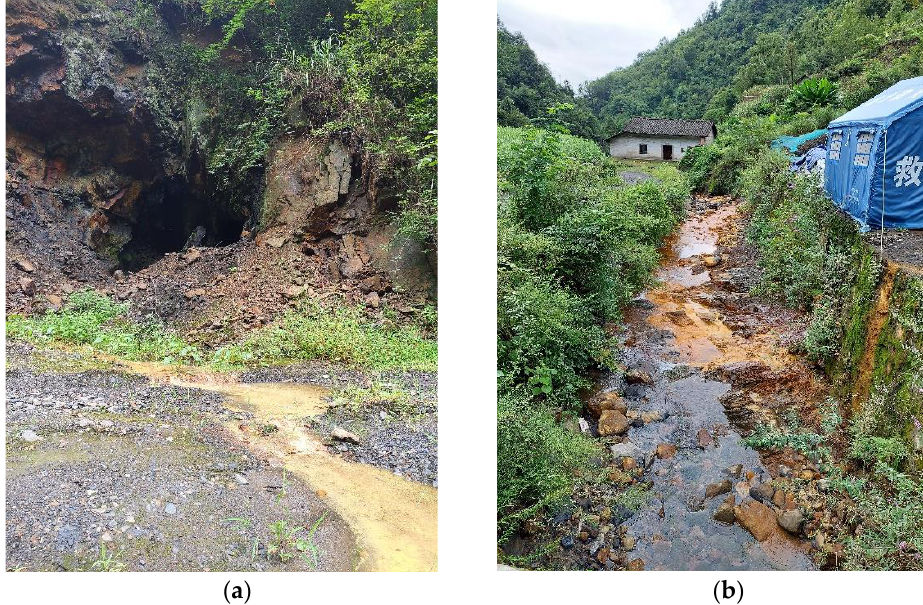
Figure 2. ( a ) The AMD flows out of the mine portal; ( b ) the Xiaomi stream polluted by AMD.